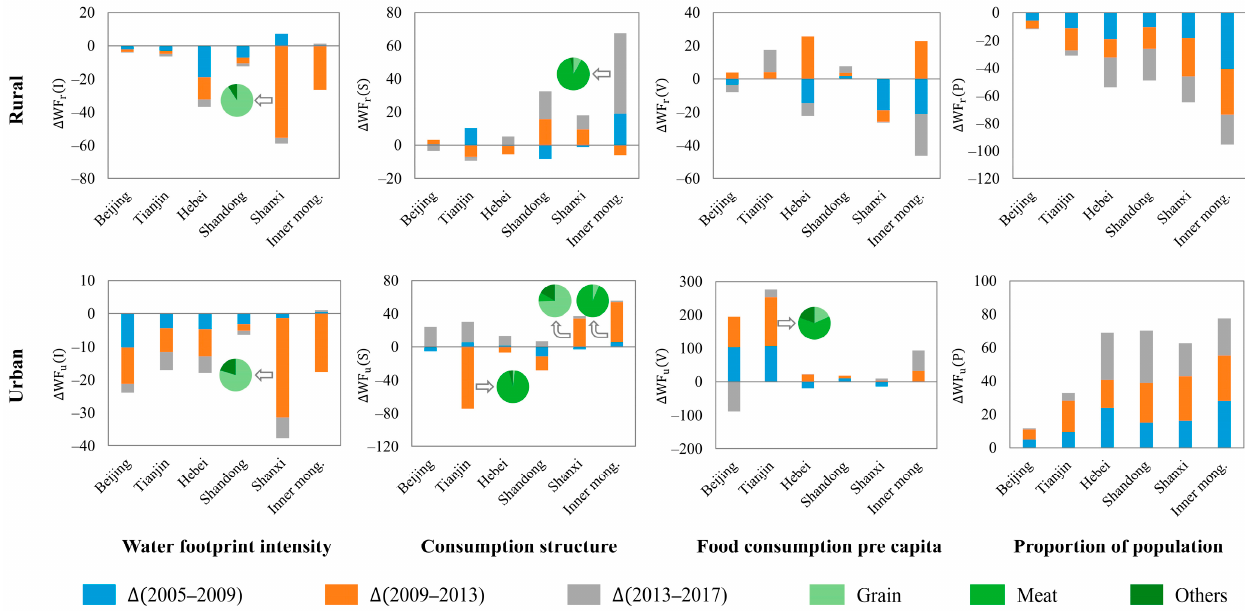
Figure 5. Decomposed contributions to the six provinces in North China’s WF changes in 2005–2017. Note: Inner Mong. (Inner Mongolia). Meat includes pork, beef, mutton, poultry, and aquatic. Others include vegetables, oil, egg, milk, sugar, fruits, and wine.